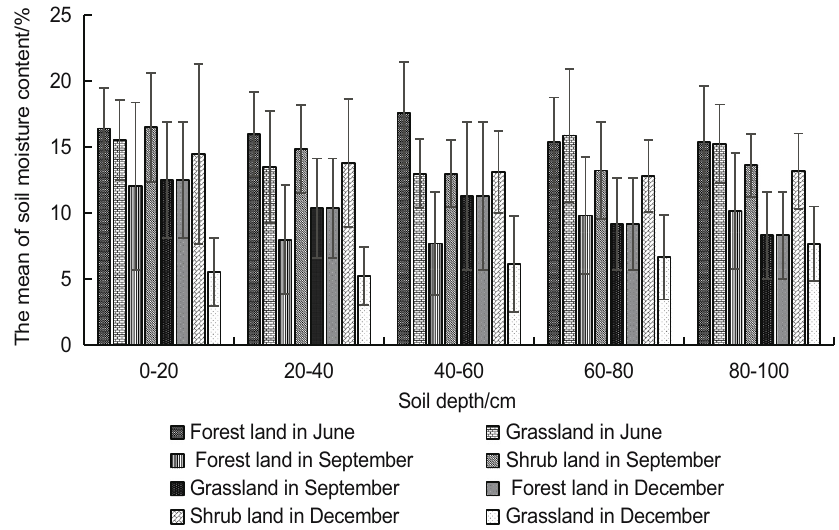
Figure 2: Characteristics of the soil moisture of di ff erent soils at various soil depths.